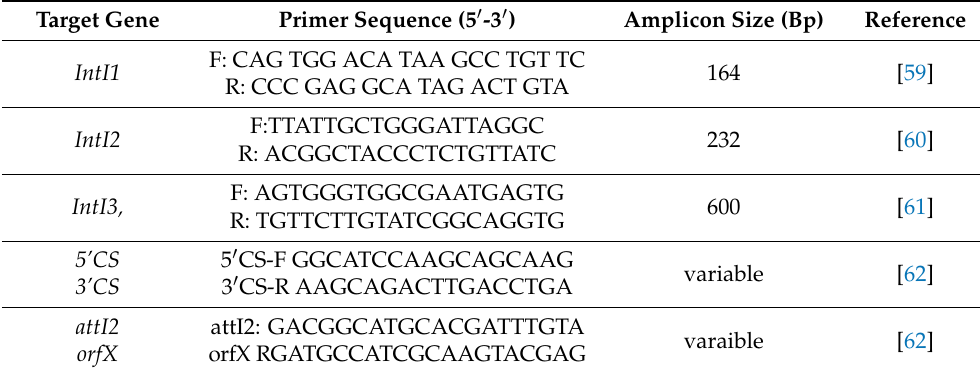
Table 4. List of primers used in this study for identification of classes of integron and internal gene